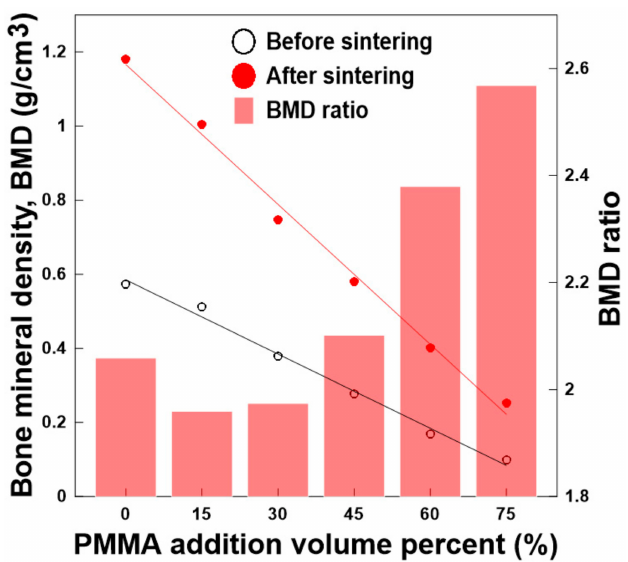
Figure 4. Bone mineral density (BMD) before and after sintering and the BMD ratio (the results after sintering / the results before sintering) with respect to the PMMA addition amount; the paired t -test for di ff erence between BMD before sintering and BMD after sintering was carried out and p <